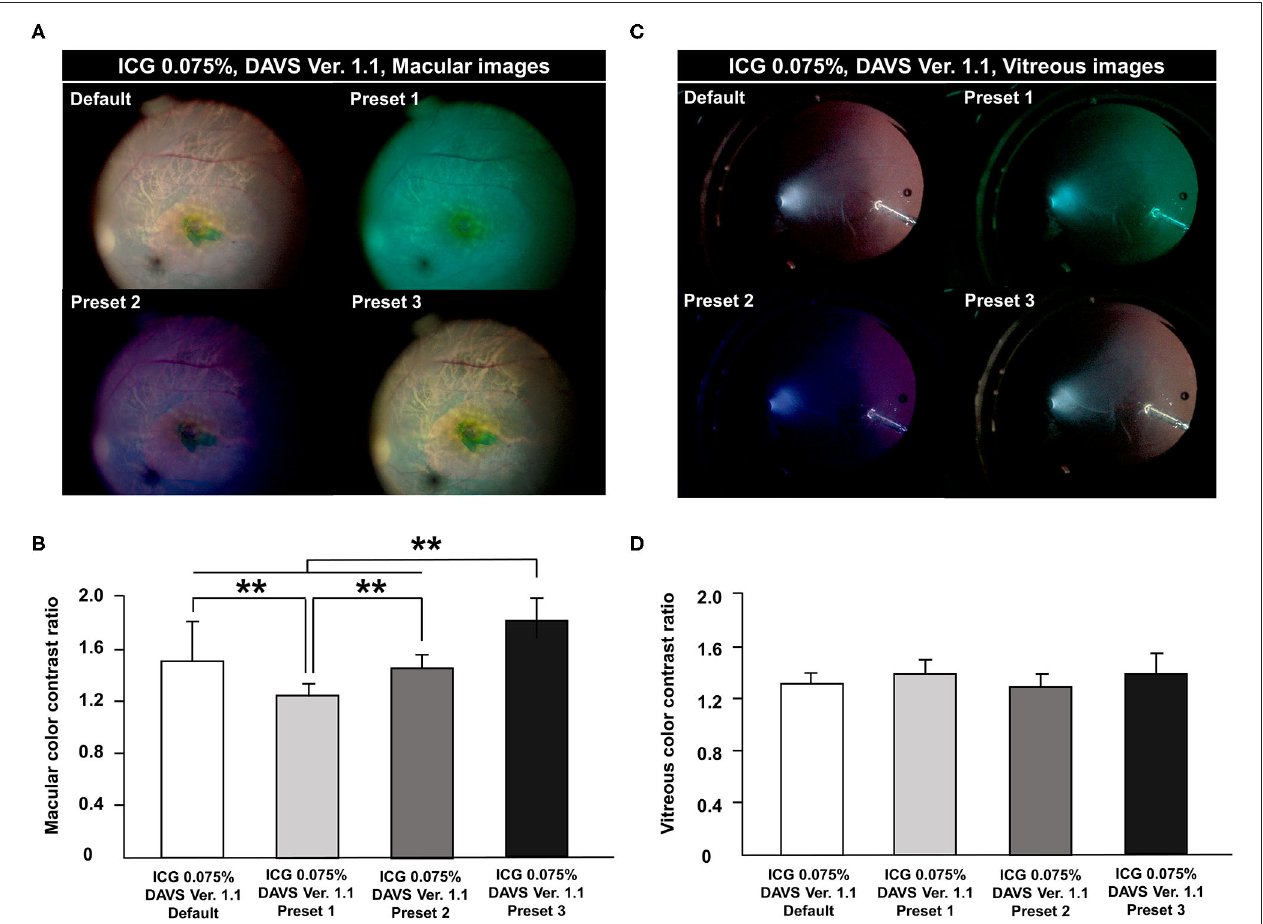
FIGURE 2 | Comparison of color contrast ratio (CCR) among channels in digitally assisted vitreoretinal surgery system (DAVS) Ver. 1.1. CCR was compared in macular and vitreous images from the DAVS Ver. 1.1 group. The following four channels were compared in each captured macular and vitreous image: Default [Red (R) 100%, Green (G) 100%, and Blue (B) 100%]; Preset 1 (R 20, G 100, B 100%); Preset 2 (R 80, G 80, B 100%); and Preset 3 (R 85, G 100, B 90%). (A,B) Macular CCR was different among the four channels ( P < 0.01). CCR was highest in Preset 3 and lowest in Preset 1 ( P < 0.01). (C,D) In vitreous images, CCR did not differ among the four settings ( P = 0.294). ** P <